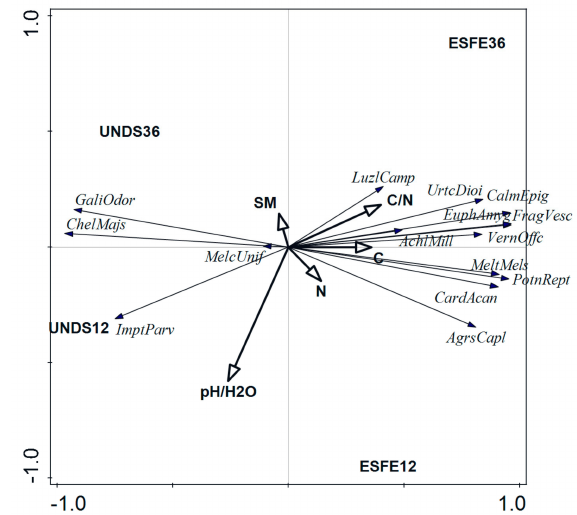
Figure 1. Redundancy analysis bi-plot of association of main understory plant species log(y + 1) and soil properties in disturbed (ESFE12, ESFE36) and undisturbed plots (UNDS12, UNDS36), 12 and 36 months after event. Plant codes are given in Table 2. SM, soil moisture (% of initial weight); pH / H 2 O, soil acidity; N, soil nitrogen content (% of dry weight); C, soil carbon content (% of dry weight); C:N, ratio of carbon to nitrogen. Eigenvalues are 0.863 (F = 11.2; p = 0.002), 0.025, 0.020, and 0.011 for first (horizontal), second (vertical), third, and fourth axes, respectively. The first two axes explained 89% of the